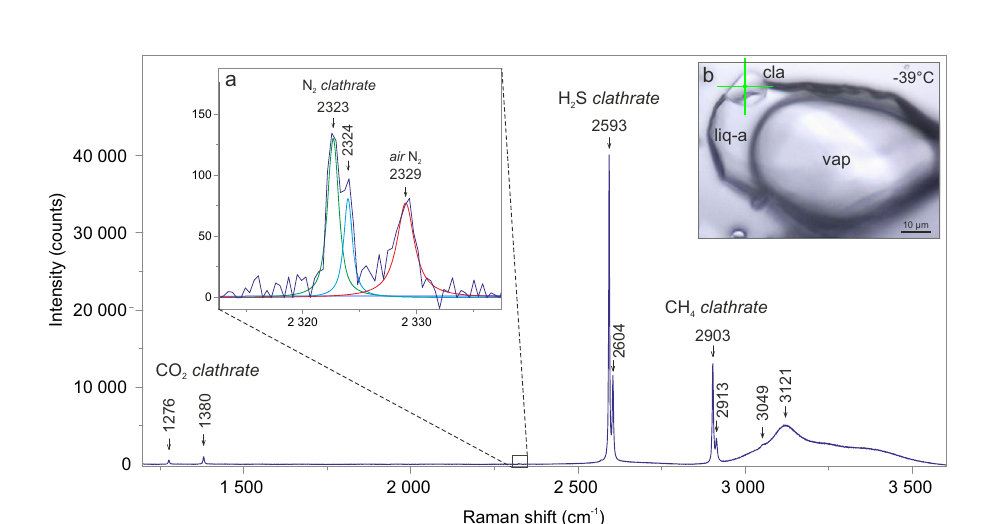
Fig. 3 Microphotographs of phase transitions in CH 4 – H 2 S – CO 2 – N 2 – H 2 O fl uid inclusion (no. P4- fi 1B) in the temperature range between + 25 and − 190 °C, PPL, re fl ected light. a One-phase gas inclusion (vap-I) at room temperature. b Formation of clathrate (cla) at the fl uid inclusion corners coated by an aqueous solution. c Exsolution of liquid H 2 S phase (liq-a). d Advanced stage of unmixing of liquid CH 4 – CO 2 phase (liq-b). e , f Instantaneous and simultaneous crystallization of liquid H 2 S and liquid CO 2 . g Nucleation of solid octahedral CO 2 crystal (sol-a) in the presence of liquid H 2 S (liq-a) by applying the cycling technique. h Nucleation of a large, oval H 2 S solid (H 2 S- α ) via applying the cycling technique. i , j Co-existence of polycrystalline solid H 2 S (H 2 S- γ ), solid CO 2 octahedral crystal (sol-a), solid CH 4 (sol-c), clathrate (cla) and CH 4 -N 2 gas phase (vap-Ib), a prismatic H 2 S- γ crystal is tagged with a white arrow. k , l Appearance of solid H 2 S after γ → β phase transformation, visible is structure change from ordered polycrystalline to disordered “ blobby ” during the heating run. Symbols and abbreviations: vap-gas phases: I: CH 4 -H 2 S-CO 2 -N 2 , Ib: CH 4 -N 2 ; cla-clathrate; liq-liquid phases: liq-a: H 2 S, liq-b: CH 4 – CO 2 , liq-c: CH 4 ; sol-solid phases: sol-a: CO 2 , H 2 S- α , β , γ : H 2 S, sol-c: CH 4 ; F-freezing run, C-cycling run, H-heating run. Green crosses mark several of Raman measurement points (see also Fig. 6).